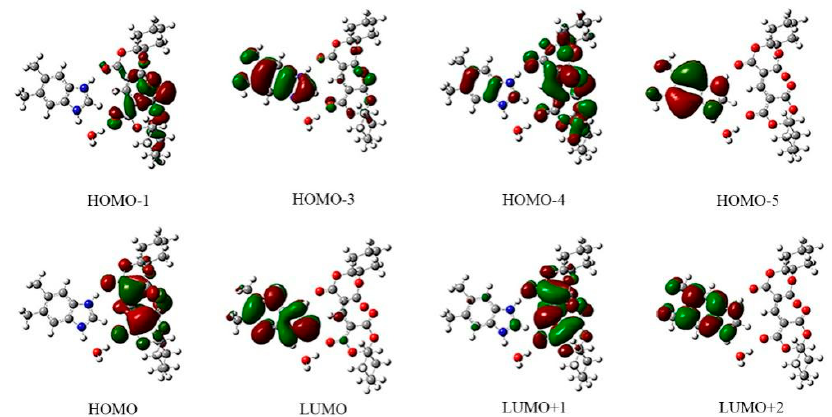
Figure 6. The eight frontier molecular orbitals of DBH .